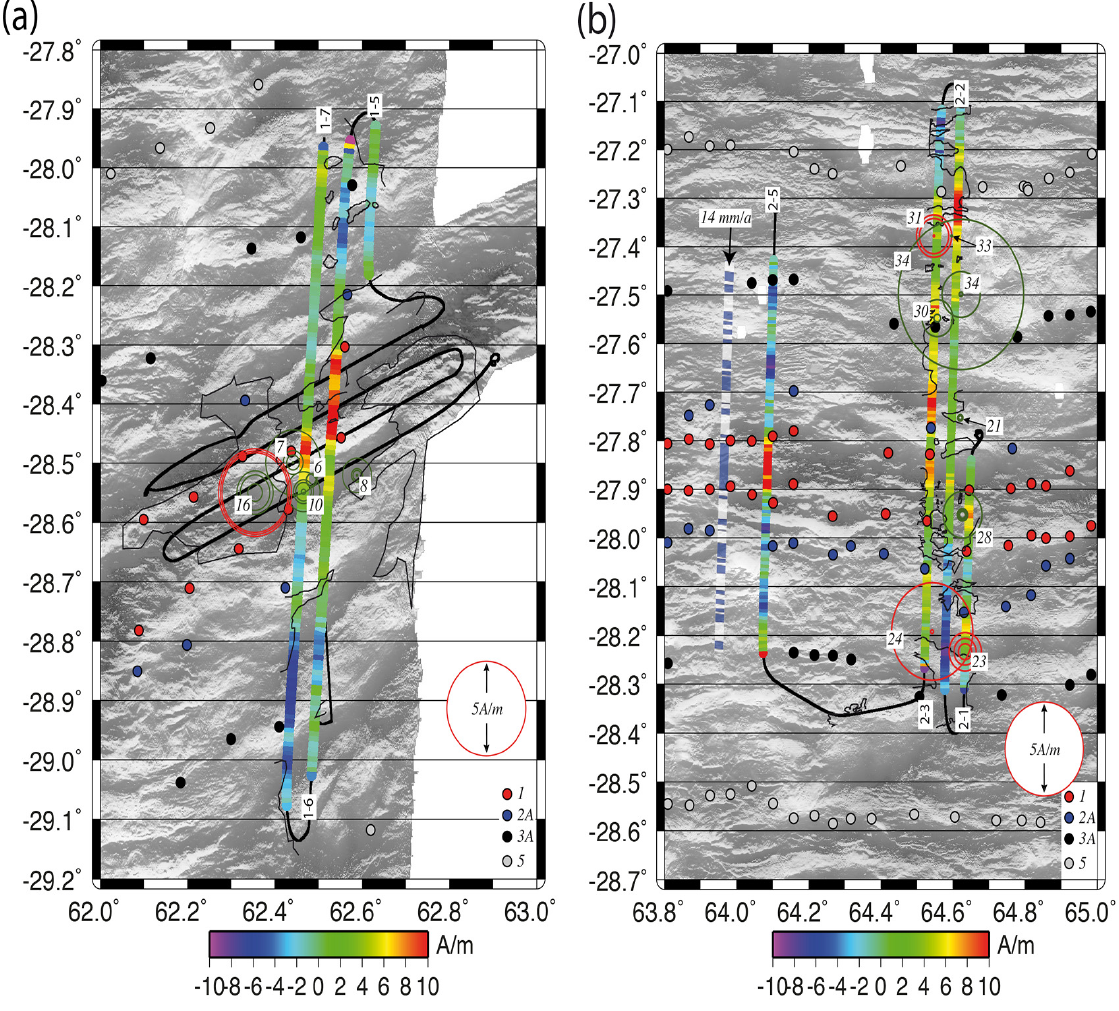
Figure 3. Inverted magnetization for the western (a) and eastern survey area (b) . Colored strips show the calculated magnetization values along the magnetic-anomaly profiles (black lines). Shaded relief images are shown in background. Red circles are sized relatively to the Natural Remanent Magnetization (NRM) values of dredged basalts whereas green circles correspond to NRM values measured on dredged peridotites (see Table 1). The dredge number is shown in the white box near the circles. The thin black lines corresponding to the edges of the volcanic seafloor are from Sauter et al. (2013). Picking of magnetic anomalies is the same as in Fig. 1. A 14mma − 1 reversal pattern is superimposed for comparison in Fig.